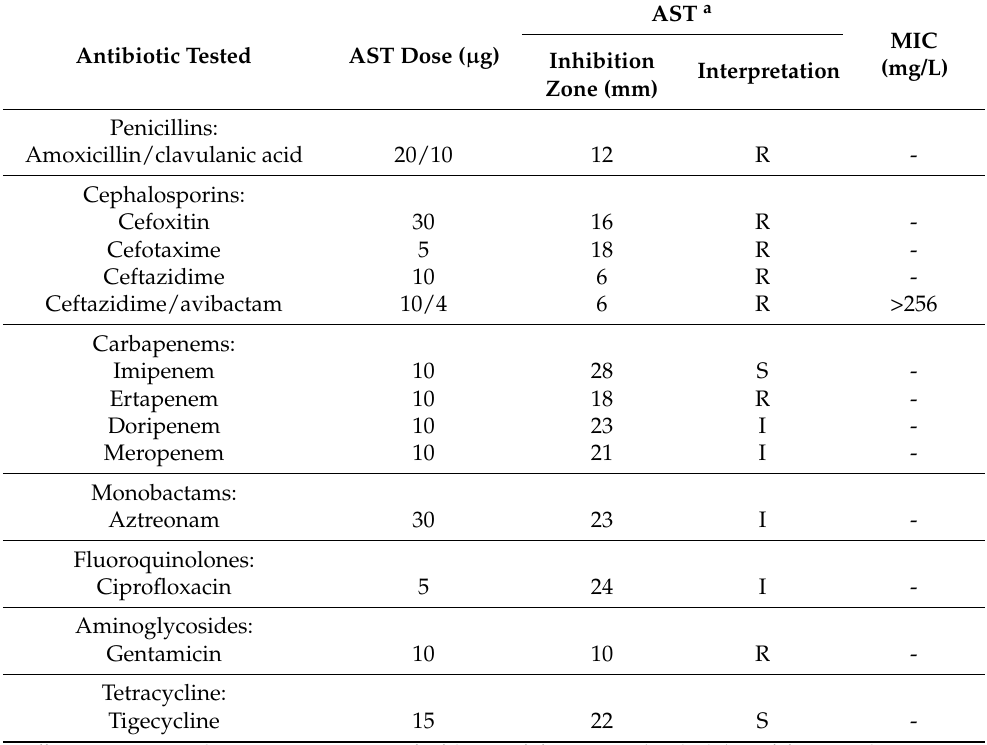
Table 1. Antimicrobial susceptibility profile from the ceftazidime/avibactam-resistant K. pneumoniae strain.